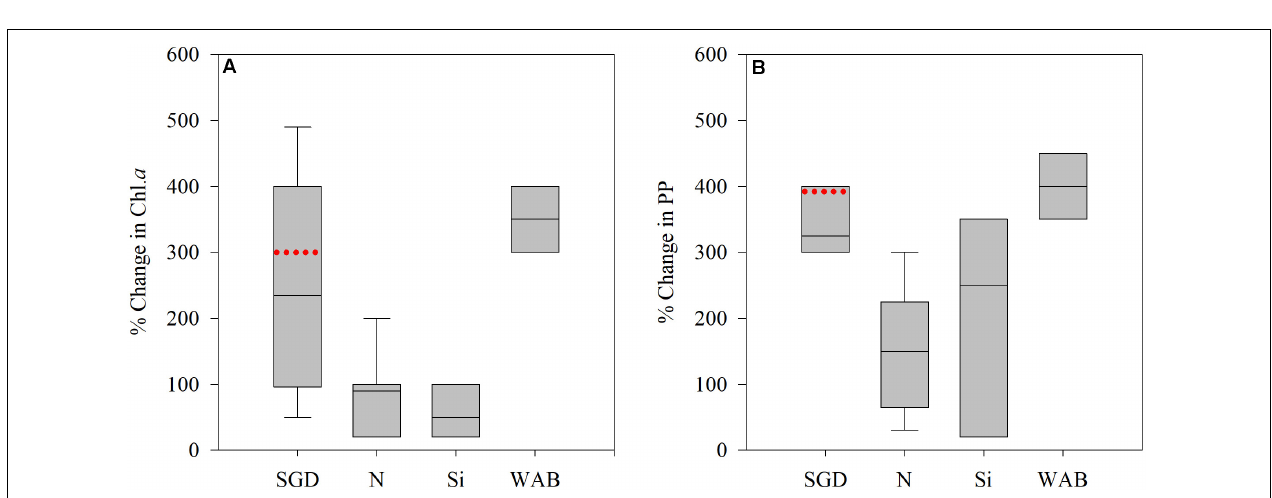
FIGURE 6 | Box-Whisker plots showing the interquartile range (25th to 75th percentile) and median value (horizontal line within the box) of the relative OTU abundances of Cyanobacteria (A) , Diatoms (B) , and Dinoflagellates (C) in Tel-Shikmona (white) and Achziv (cyan) between 2014 and 2016. Data derived from 16S and 18S rDNA analyses ( n = 4). The measured values used to generate the box-plots are shown in gray.